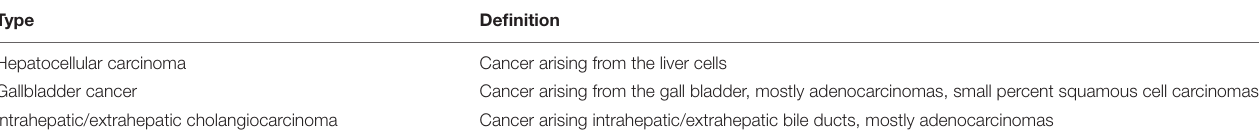
TABLE 1 | Definitions of different types of hepatobiliary